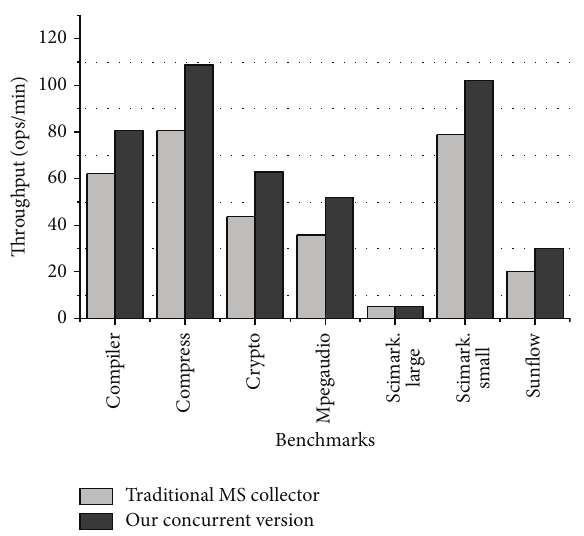
Figure 5: Throughput measurement results with SPECjvm2008 benchmark suite.